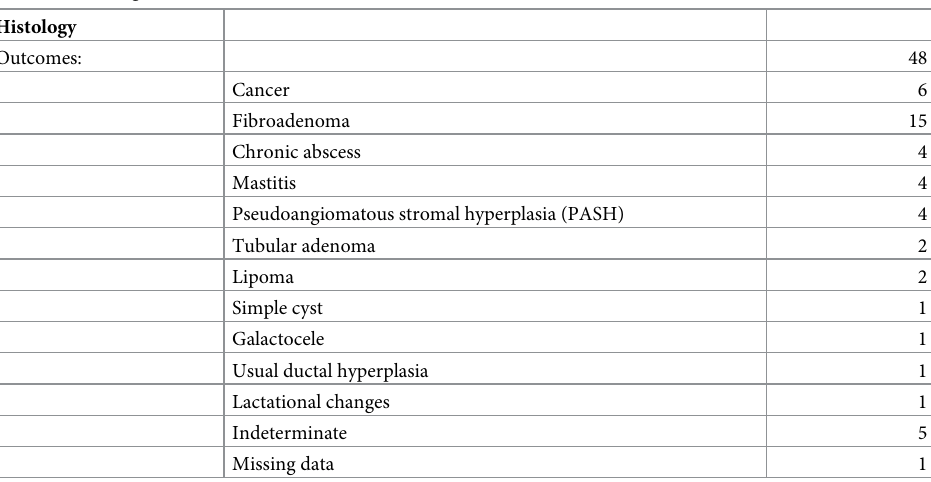
Table 3. Histologic